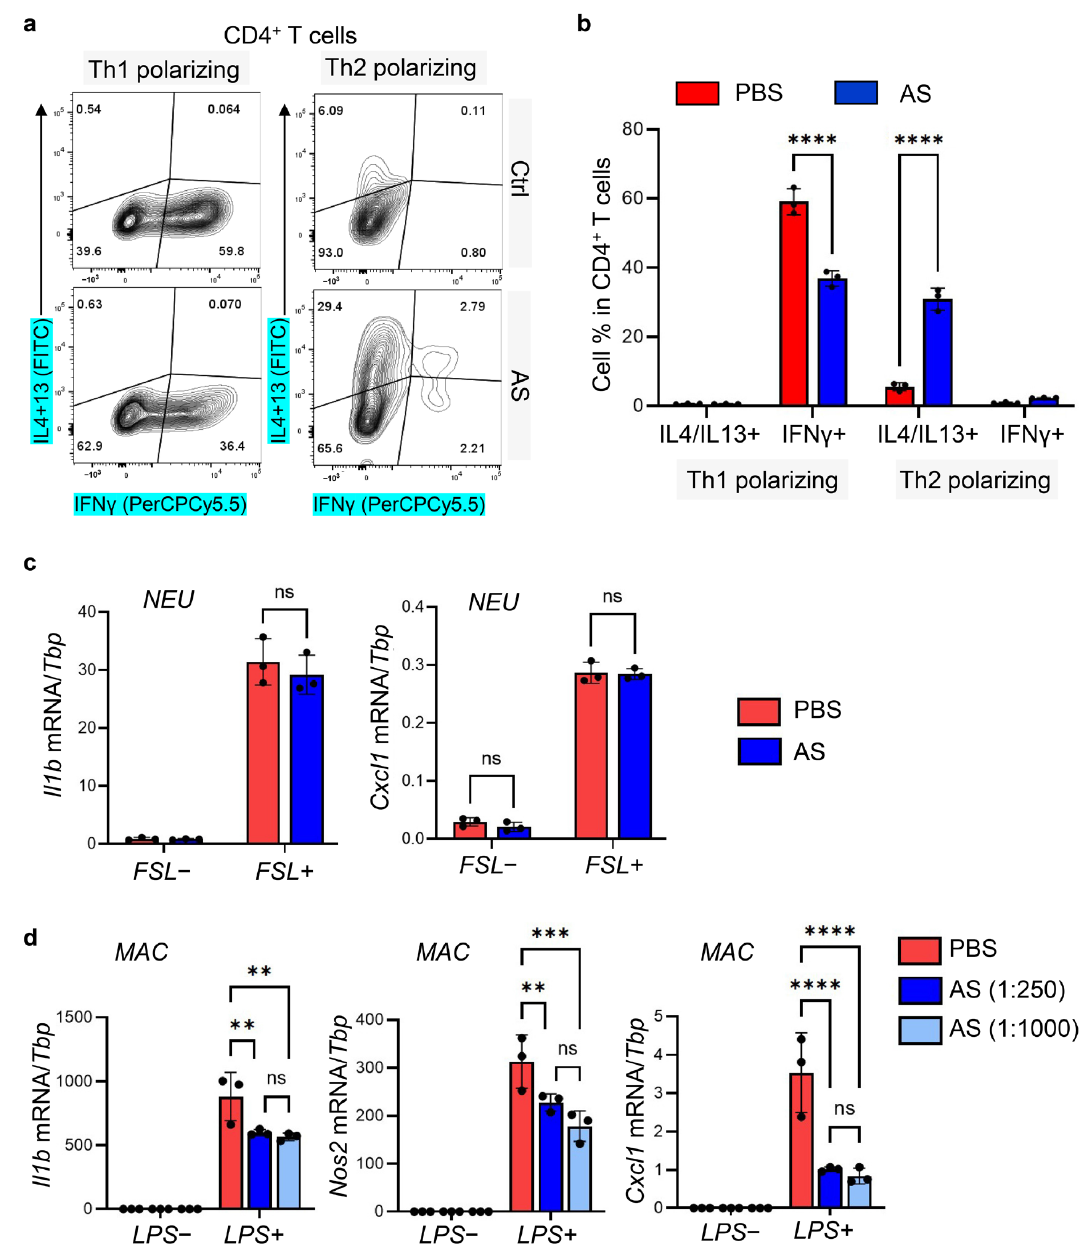
Figure 6. The in vitro effect of aluminum salt in modulating T cell differentiation and myeloid cell activation: ( a ) FACS plots analyzing the expression of IFN γ and IL4/IL13 in primary CD4+ T cells cultured under Th1- or Th2- polarizing conditions with or without AS (1:250). ( b ) quantified bar graphs showing the percentage of IL4/IL13+ or IFN γ + CD4+ T cells ( n = 3/group); ( c ) Primary neutrophils isolated from bone marrow were stimulated with TLR2 agonist FSL with PBS or AS (1:250), and cells were subjected to qRT-PCR analysis of Il1b or Cxcl1 mRNA expression as indicated ( n = 3/group); ( d ) Primary peritoneal macrophages were stimulated with TLR4 agonist LPS with PBS or AS (1:250 or 1:1000 as indicated), and cells were subjected to qRT-PCR analysis of Il1b , Cxcl1, or Nos2 mRNA expression as indicated ( n = 3/group). All error bars indicate mean ± SEM, and statistical analysis was performed by two- way ANOVA with Bonferroni -corrected multiple comparisons. ** p < 0.01, *** p < 0.001, **** p < 0.0001, ns, non-significant.